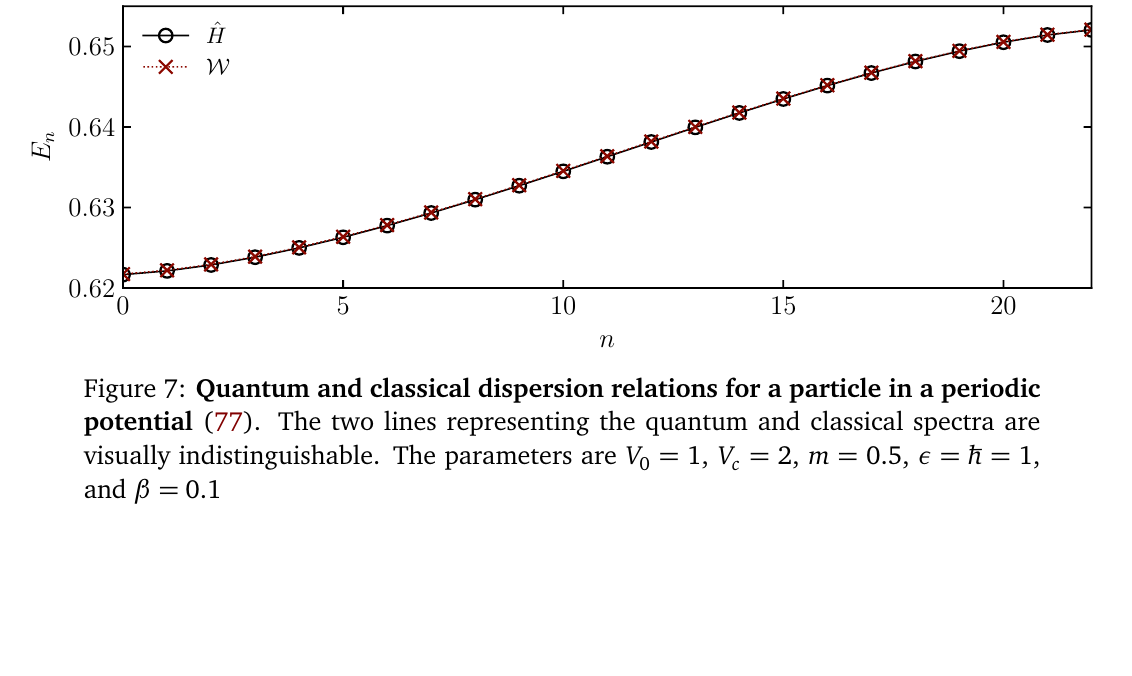
= 1, V = 2, m = 0.5, ε = ħ h = 1, c 0